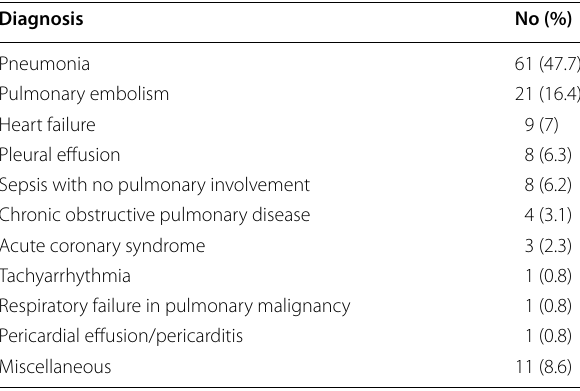
Data are given as no. (%) unless otherwise indicated